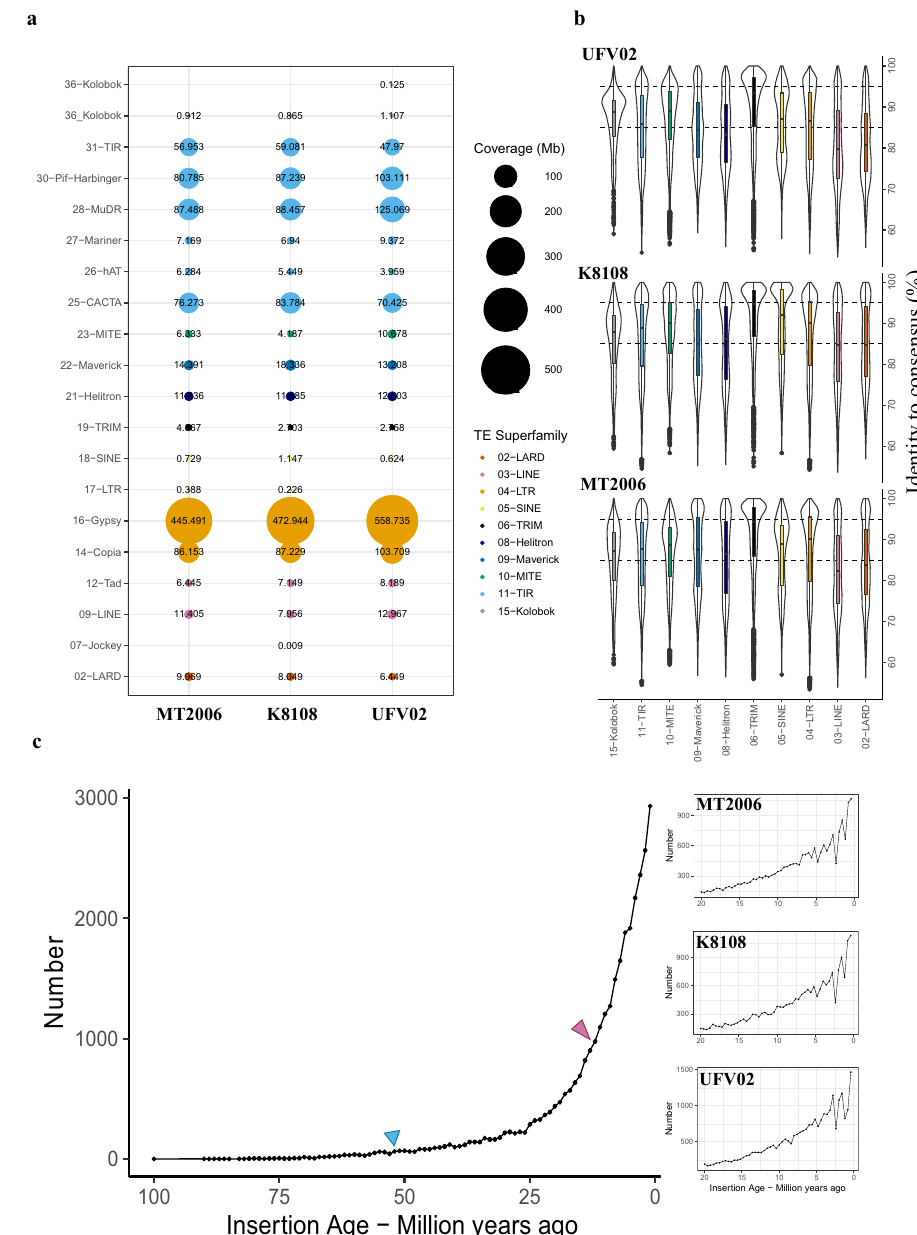
Fig. 2 | Transposable element superfamilies in the P. pachyrhizi genomes, K8108, MT2006 and UFV02. a Genome coverage of different TE superfamilies in three P. pachyrhizi genomes. b TE superfamilies are categorized based on the consensus identity, (1) conserved TEs, copies with more than 95% identity (2) intermediate TEs, copies with 85to 95%identity and (3) divergent TEs, copies with less than 85% identity. Violin plots indicate: vertical line represents distribution at Q1-1.5 × IQR and Q3+1.5 × IQR, dots represent independent data points, fi rst quartile (lower bar), median (thick line), third quartile (upper bar), and the shape